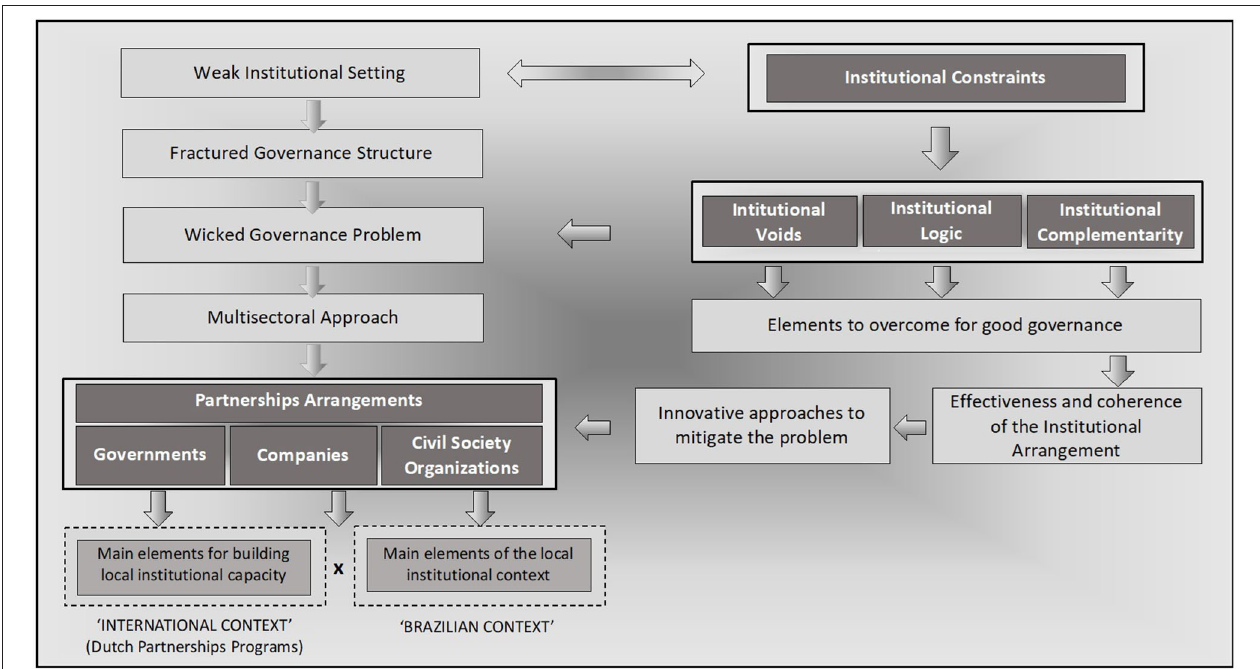
FIGURE 1 | An institutional approach to address weak institutions and wicked problems.